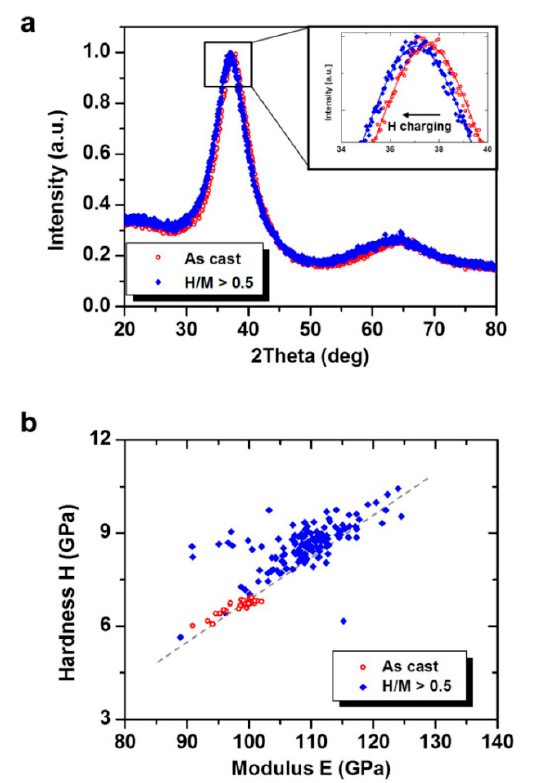
Figure 1. ( a ) X-ray diffraction spectra of Vit 105 metallic glass (MG) samples with and without hydrogen charging. The hydrogen content is defined as the hydrogen-to-metal ratio. ( b ) Hardness and modulus (Berkovich indentation) of samples with and without hydrogen charging. The dashed line is to guide the eye.